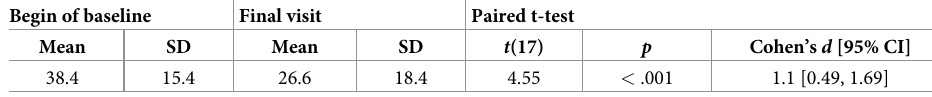
Table 2. Improvement of THI from begin of baseline phase to final visit. Begin of baseline Final visit Paired t-test Mean SD Mean Mean and standard deviation of the Tinnitus Handicap Inventory (THI) score at begin of baseline phase and final visit. Paired t-test reveals a statistically significant improvement from baseline to final visit with a strong effect size. N = 18.